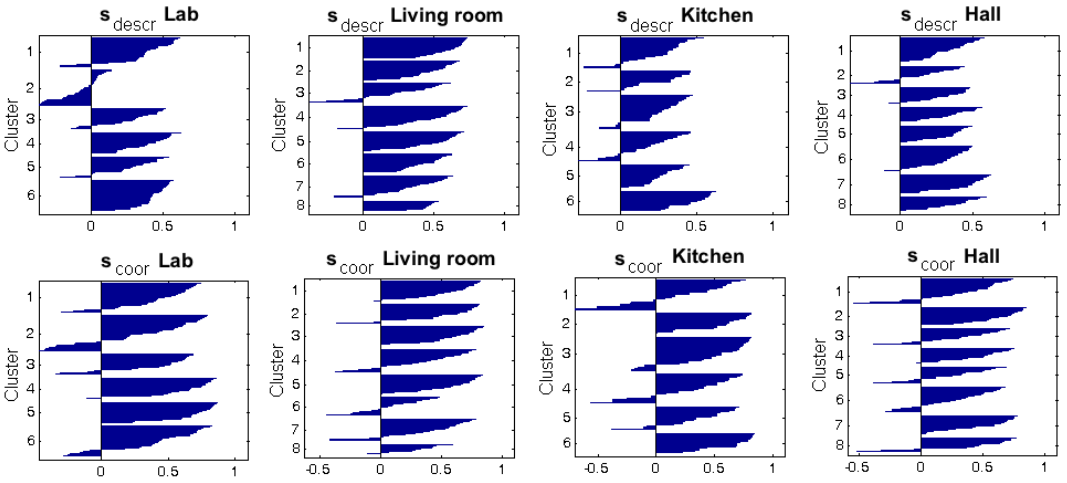
Figure 15. Results of the intermediate-level mapping using gist with m = 16 masks and k 6 = 4 horizontal blocks. Top row: silhouettes of the entities (visual descriptors). Bottom row: silhouettes of the coordinates of the capture